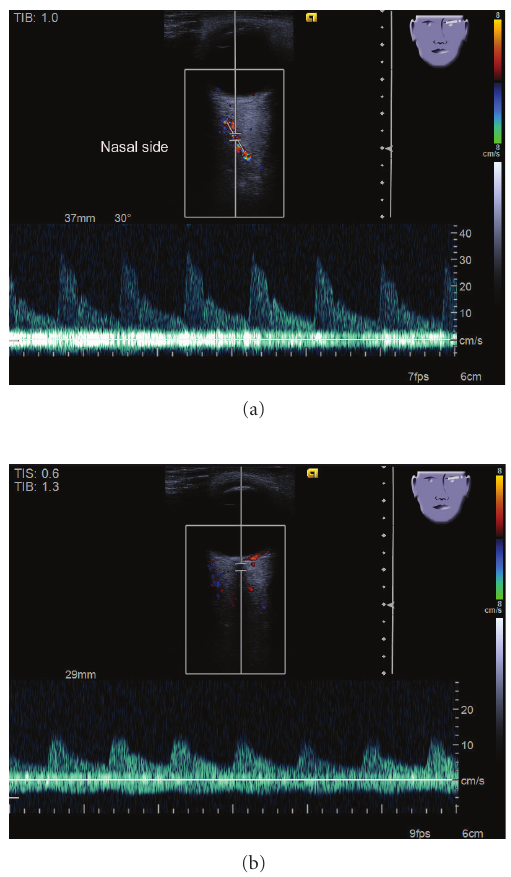
Figure 1: Color Doppler flow imaging of the ophthalmic artery (a) and central retinal artery (b) in normal